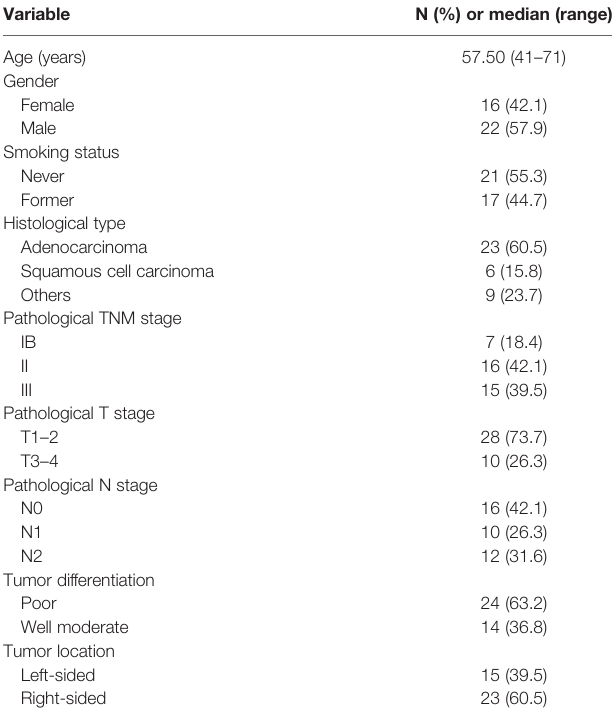
TABLE 1 | Patient characteristic and demographics of eligible patients (N =